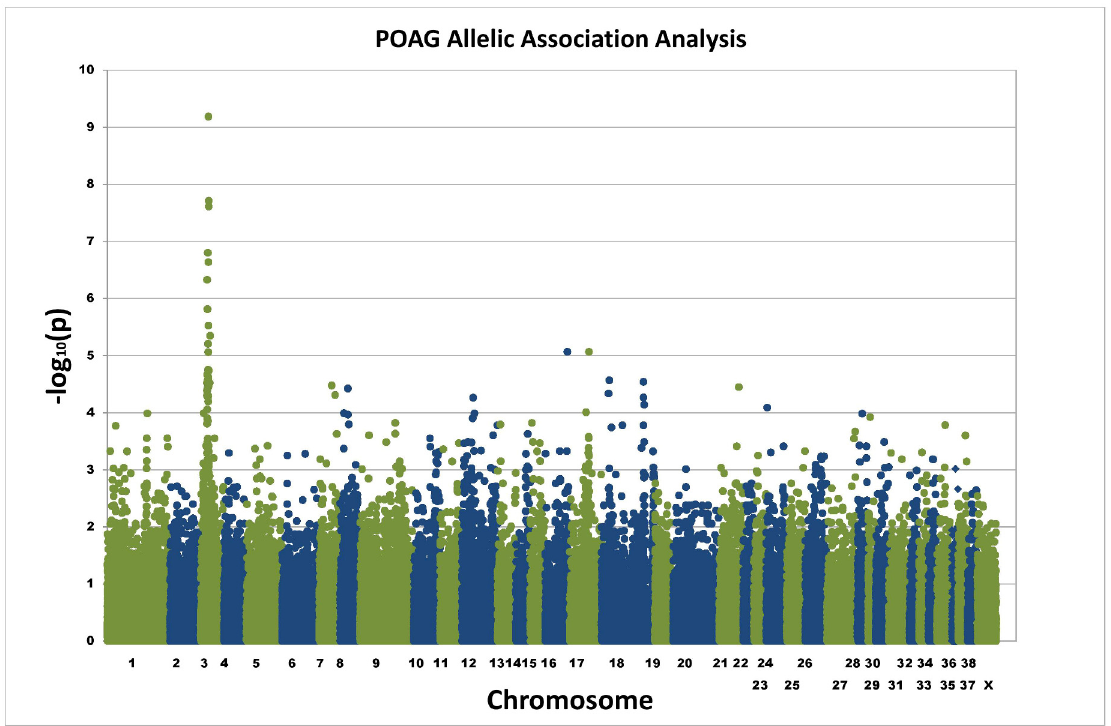
Fig 2. Allelic association plot for POAG GWAS. Exome sequencing was used to generate SNPs for 12 POAG cases and 12 controls. Allelic association analysis identified a single signal on chromosome 3 of genome-wide